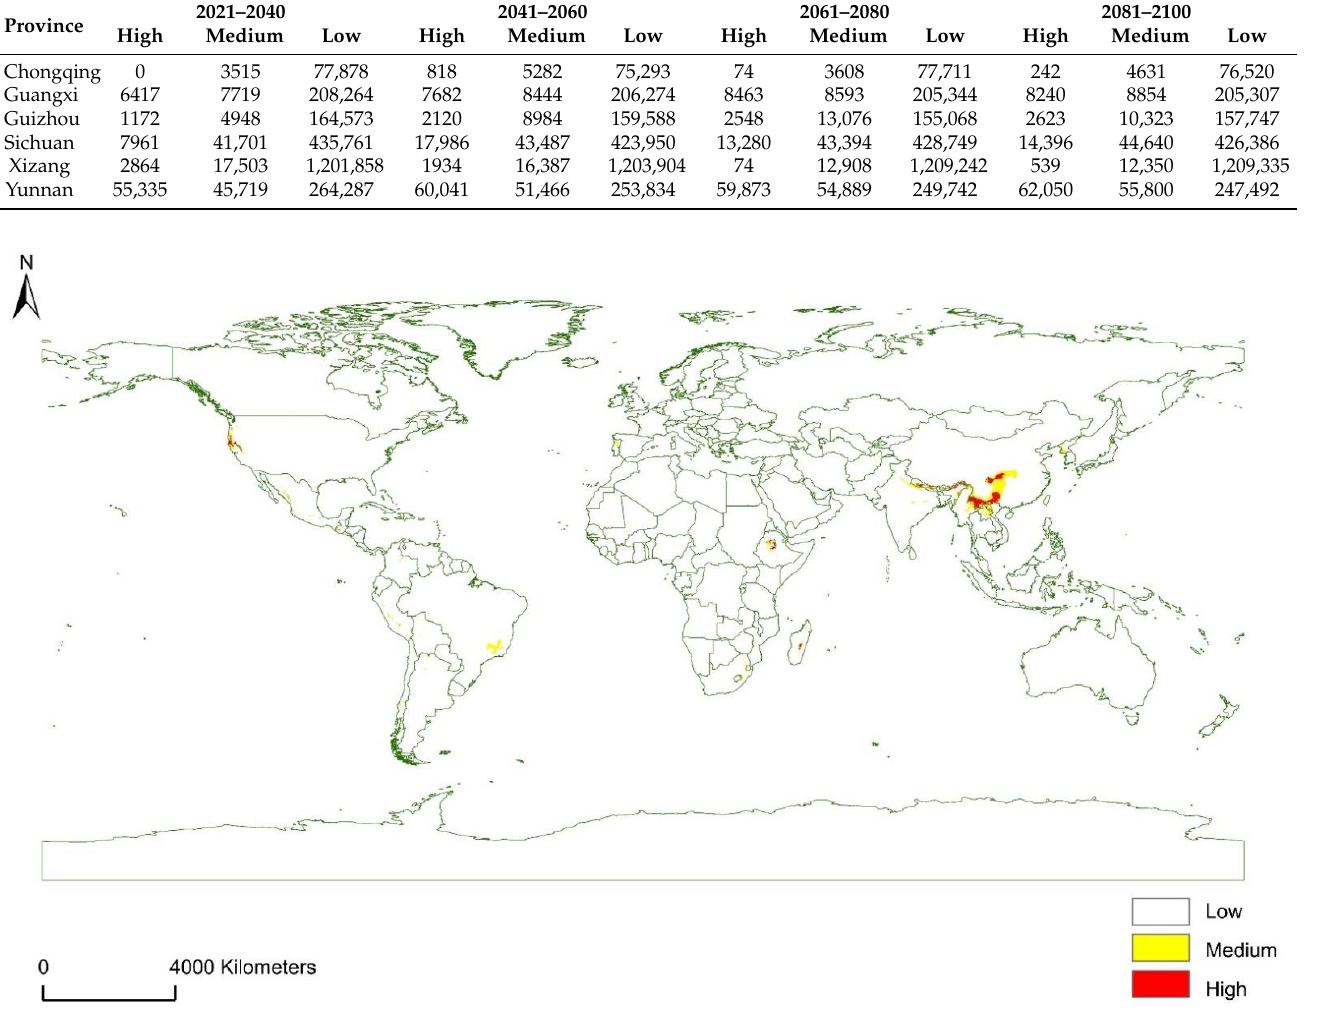
Figure 6. Potential niches of ancient Pu’er tea trees for 2021–2100 (averaged) in the world. The classes represent levels of environmental suitability.